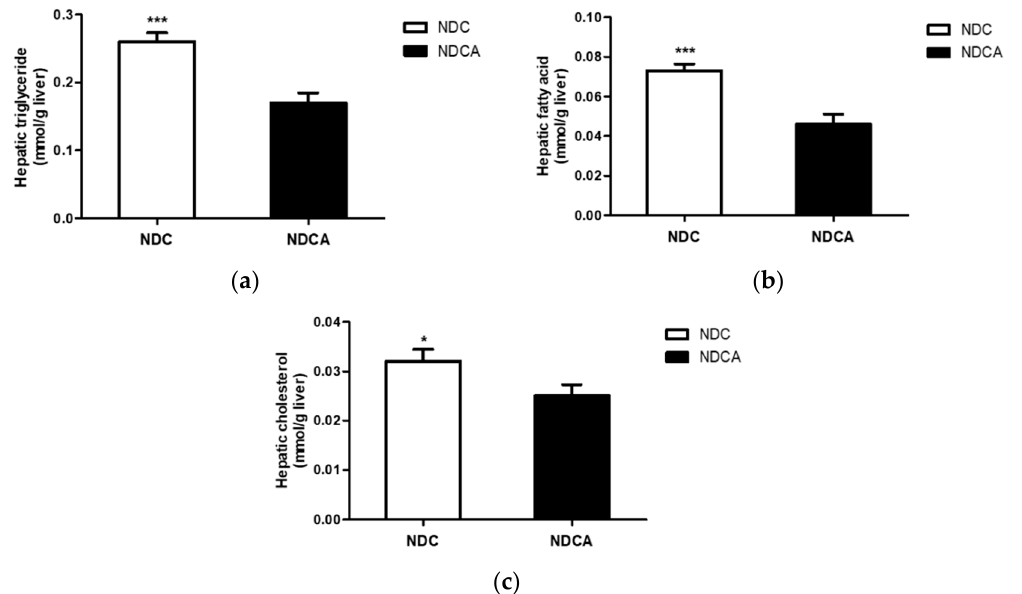
Figure 5. Effect of supplementation of non-dairy creamer-enriched high-fat diet with D-allulose on changes in hepatic lipid levels in C57BL/6J mice fed the diet for 8 weeks: ( a ) hepatic triglyceride; ( b ) hepatic fatty acid; ( c ) hepatic cholesterol. Data are mean ± SE. Significant differences between the 5% D-allulose group and without D-allulose group are indicated; * p < 0.05, *** p < 0.001. NDCA, high-fat diet with non-dairy creamer + 5% D-allulose; NDC, high-fat diet with non-dairy creamer.